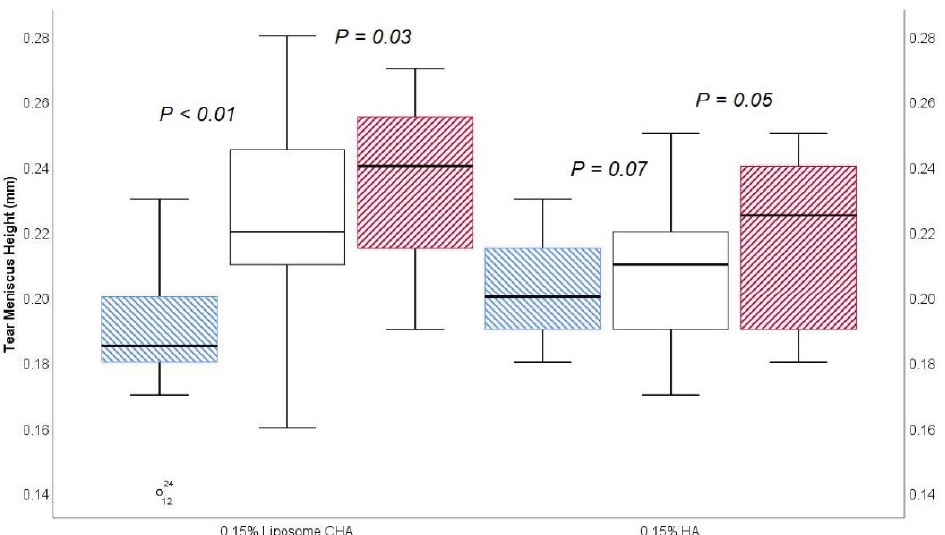
Figure 3. Box and plot of tear meniscus height assessment before (blue), 30 min (white), and 45 min (red) after eyedrop instillation.